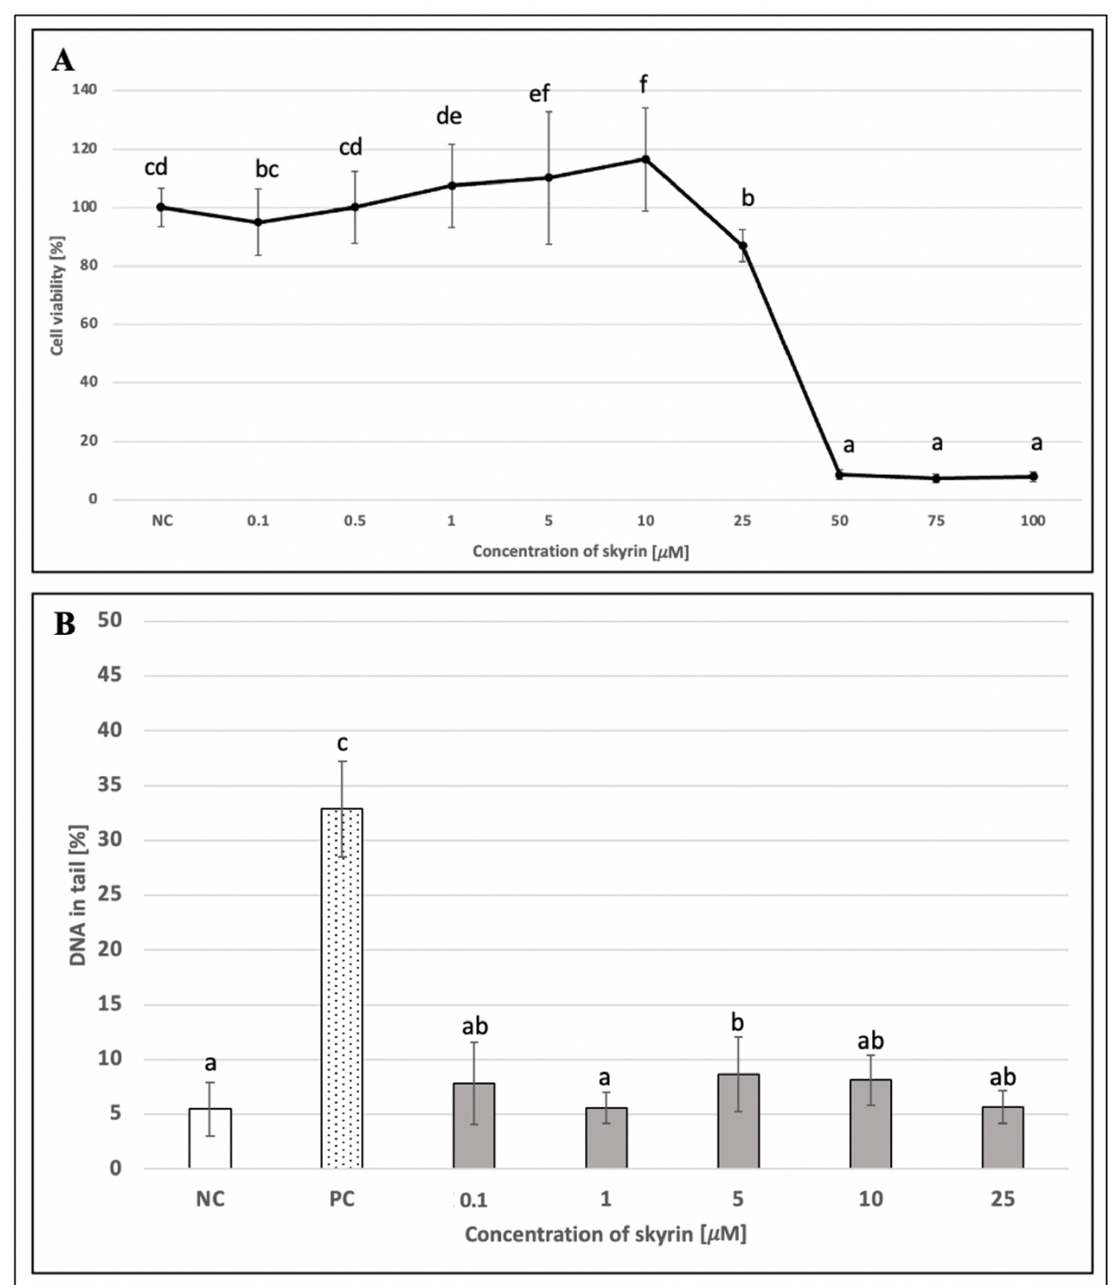
Figure 9. Evaluation of the potential cytotoxic ( A ) and genotoxic ( B ) effects of skyrin (SK) on the HepG2 cell line (48 h treatment) at different concentrations, using MTT and the comet assays. Negative control (NC)—untreated cells; positive control for comet assay (PC)—cells treated with 1 mM hydrogen peroxide. Results were analyzed by ANOVA single-step multiple comparisons of means using LSD tests, and comparisons between the mean values were considered significant at p < 0.05. Similar letters represent samples with no statistically significant differences between them. All experimental data in this work are from at least three independent experiments.